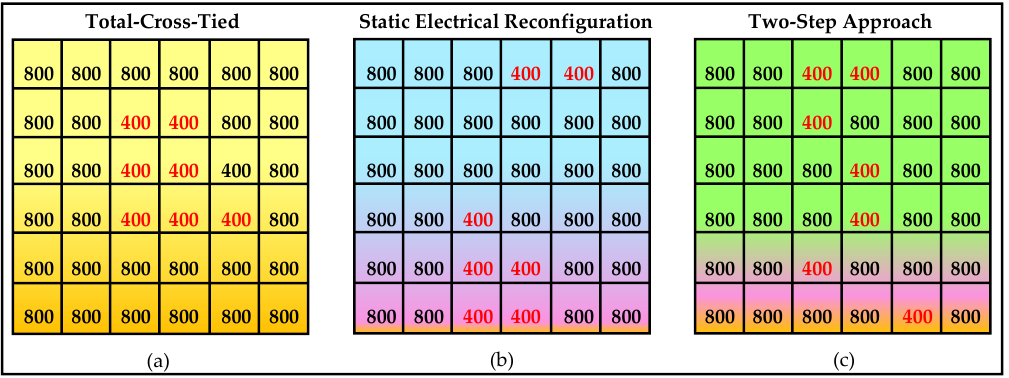
Figure 10. Graphical comparison of the two-step approach under partial shading S2. ( a ) P~V curve comparison with conventional configurations, ( b ) P~V curve comparison with hybrid configura-tions, ( c ) P~V curve comparison with the static reconfiguration technique, and ( d ) comparison of parameters among all configurations.